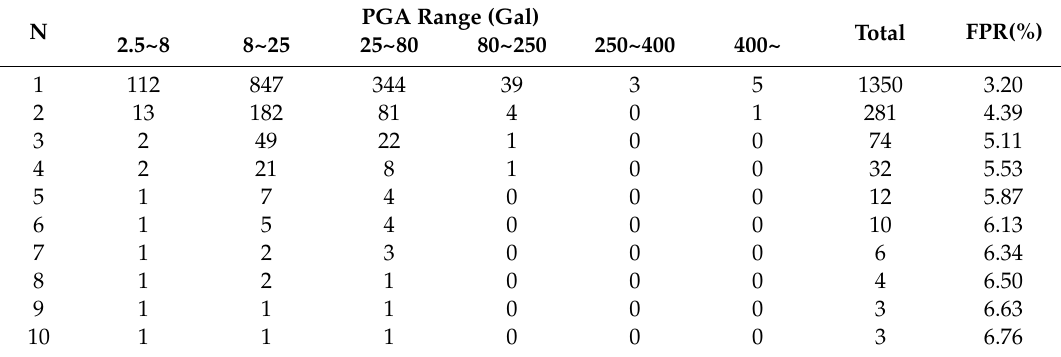
Table 2. The number of missed earthquakes among all 77,994 earthquake data of different PGA ranges after N seconds. The FPRs of all 49,094 non-earthquake cases after N seconds are also listed. (LG Stylus). PGA Range (Gal) N